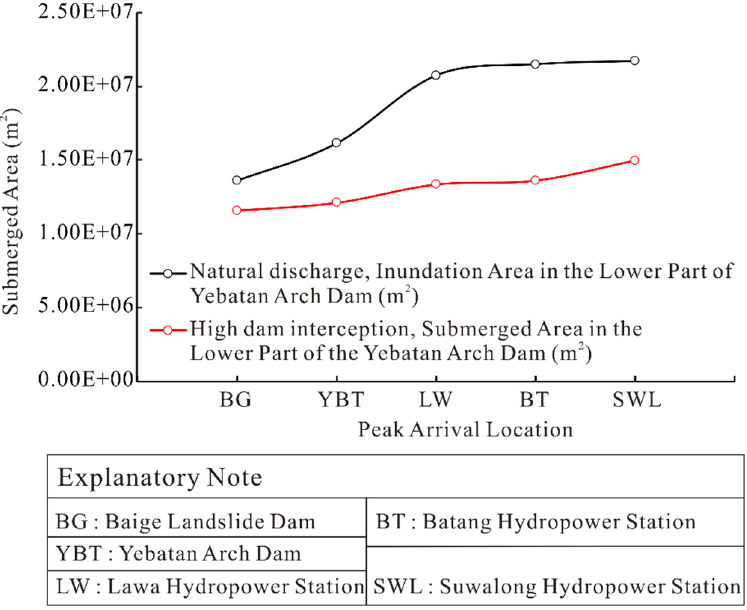
Figure 15. Comparison of the downstream inundation area of the Yebatan arch dam for the natural discharge and high dam interception.